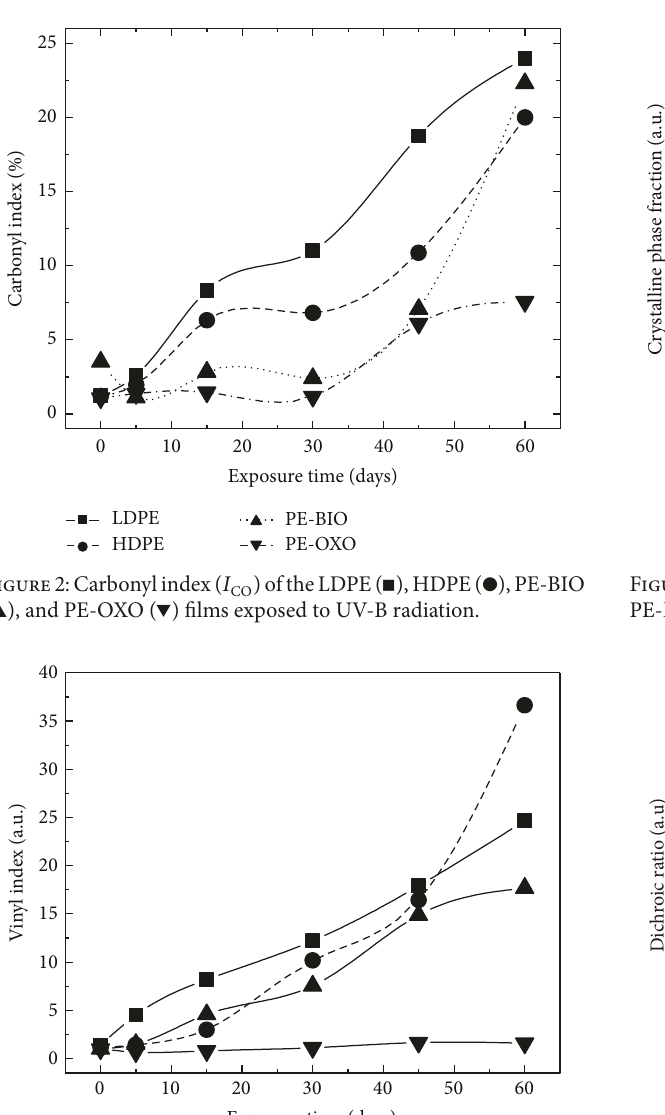
60 50 40 30 20 10 0